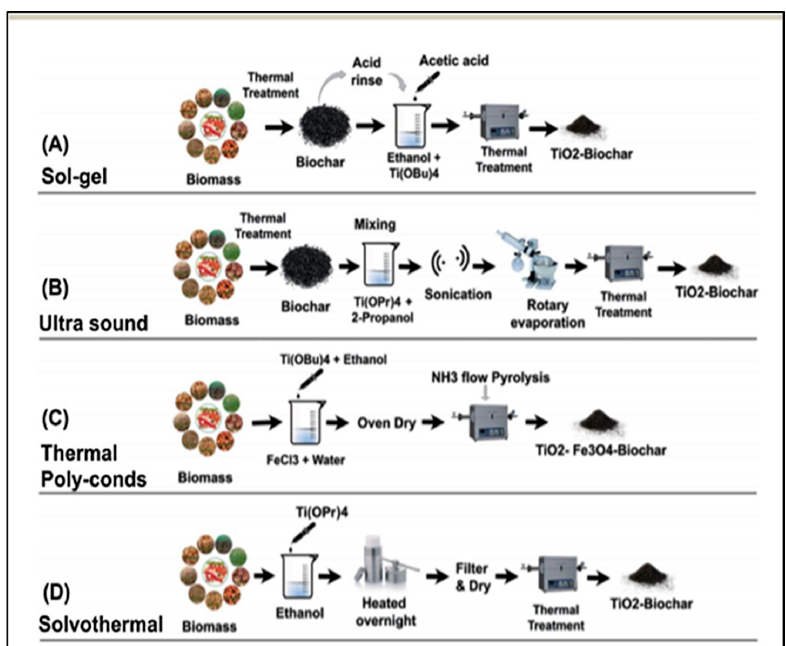
Figure 5. Illustration of various methods to develop biochar-supported TiO 2 nanocomposite material for photocatalysis: ( A ) Sol-gel method, ( B ) Ultra sound method, ( C ) Thermal Polycondensation method, and ( D ) Solvothermal method for the synthesis of biochar supported TiO 2 nanocomposite (reproduced from [73] Copyright year 2018, RSC Advances with permission under Creative Commons Attribution 3.0 Unported Licence).